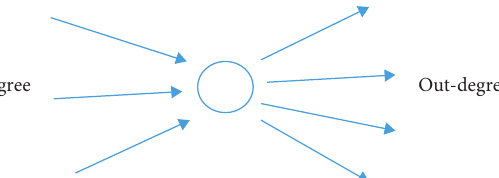
Figure 1: Degree centrality of a vertex. Source: composed by the